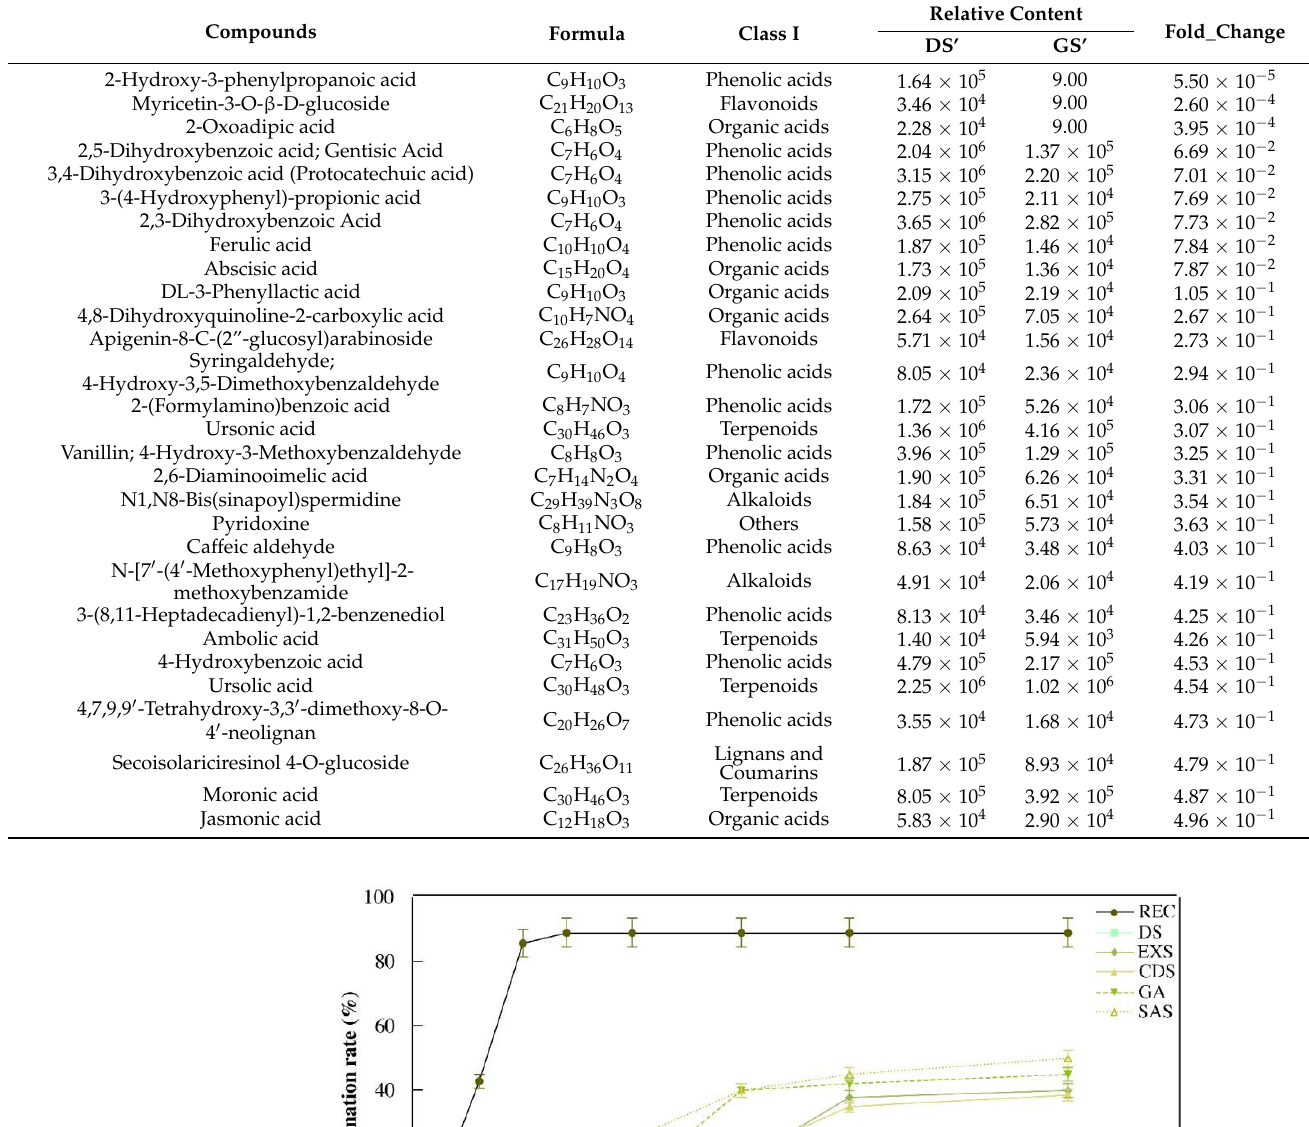
Table 1. Potential endogenous inhibitors of Chinese pistache seeds by fold change.